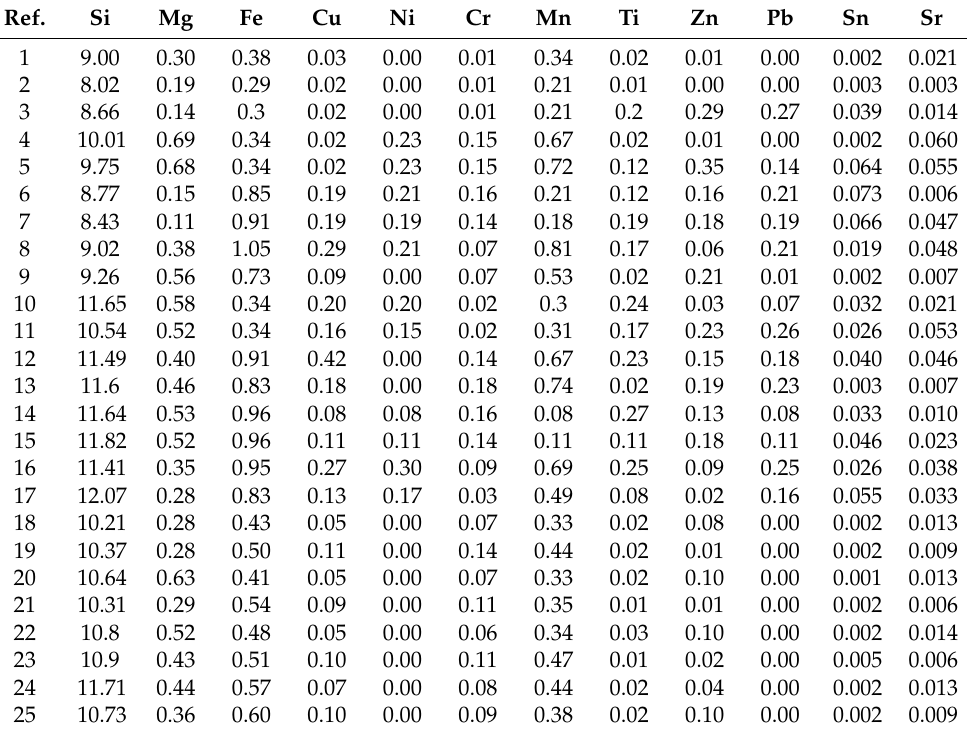
Table 1. Composition of studied alloys